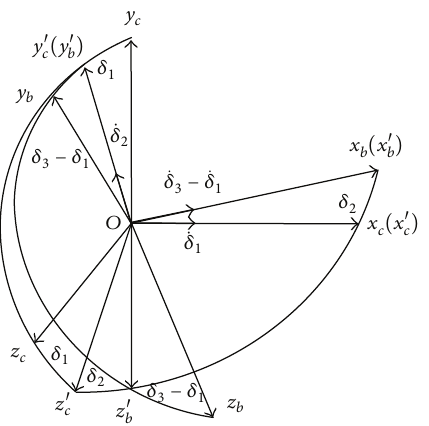
Figure 2: Rotational relationship of 𝑂𝑥 𝑐 𝑦 𝑐 𝑧 𝑐 and 𝑂𝑥 𝑏 𝑦 𝑏 𝑧 𝑏 .